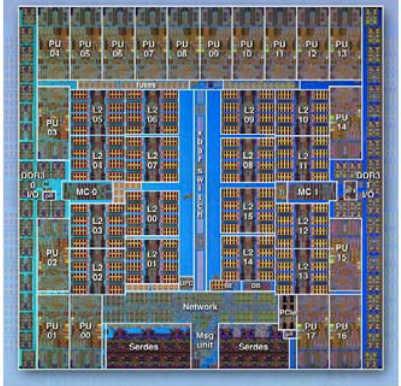
Figure 1. A die photograph of BlueGene/Q Chip [3]